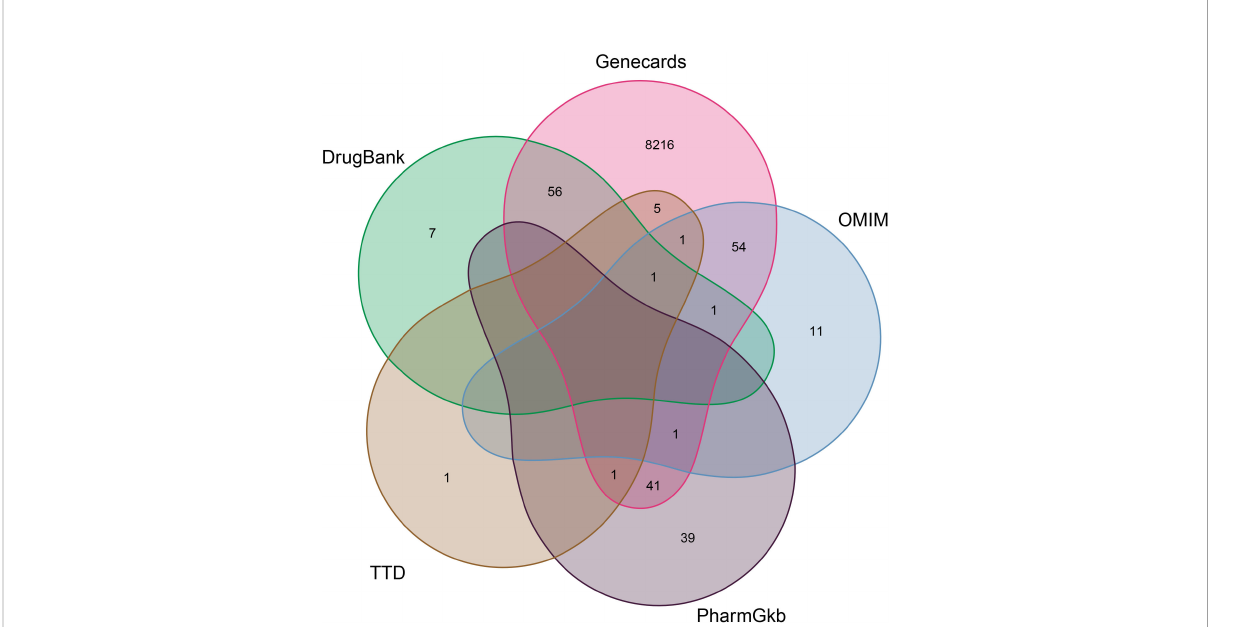
analysis in STRING. Table 3 and Figure 7 showed the screening of genes according to the median values of DC, CC, EC, LAC, and NC, and a vivid description of the process, targets for CKI to participate in the regulation and treatment of lung adenocarcinoma.